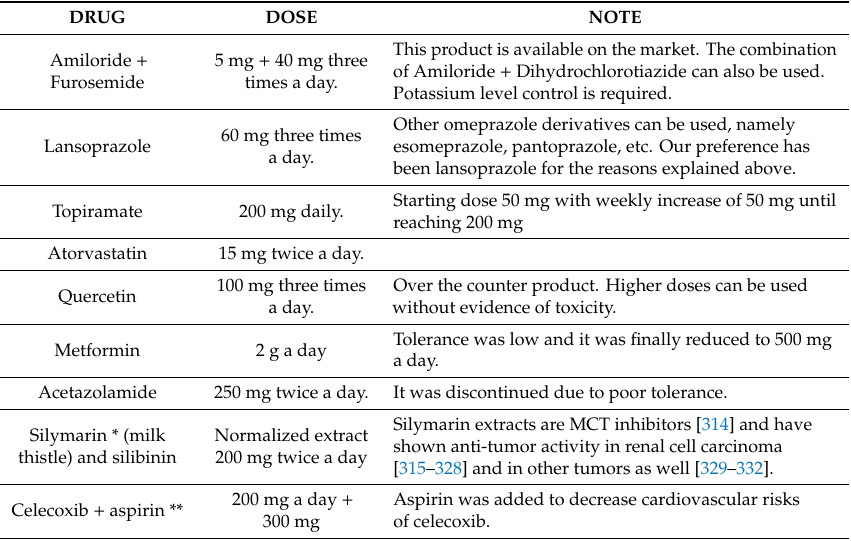
Table 1. Drug scheme used in case